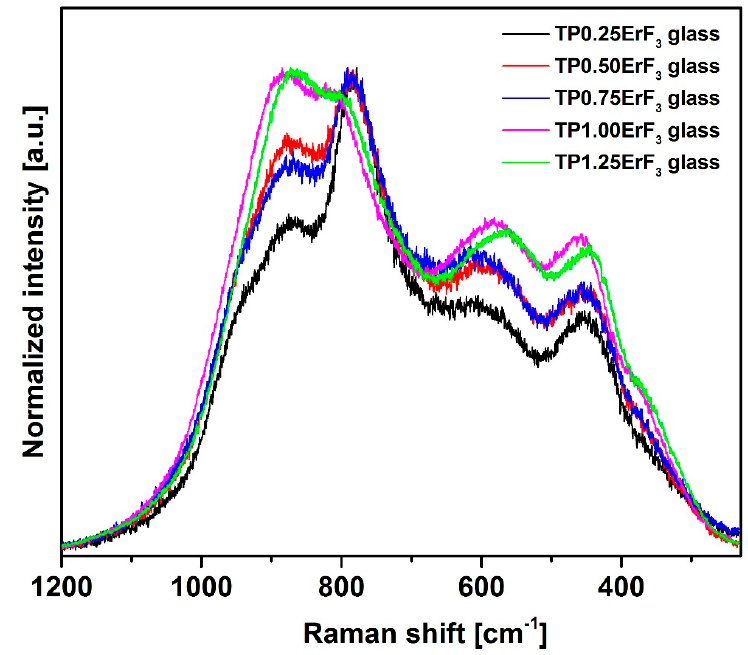
Figure 8. Raman spectra of precursor glass doped with varying ErF 3 content.